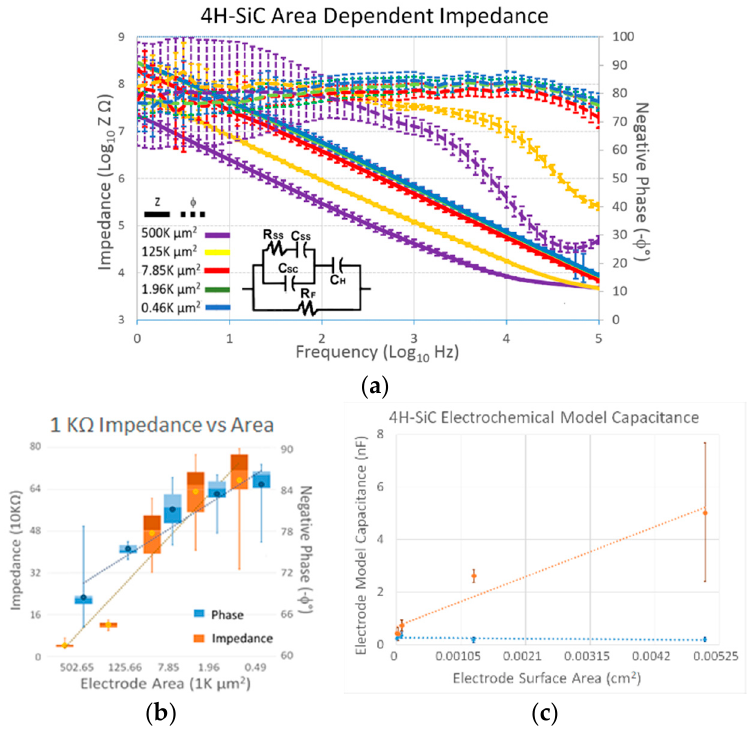
Figure 3. ( a ) Electrochemical impedance spectroscopy (EIS) performed on 4H ‐ SiC electrodes of varying geometrical surface areas (GSA). The error bars represent the standard deviation. The inset shows the basic circuit model which produced an impedance profile which was similar to that which was obtained in experimental investigation. ( b ) A box and whiskers plot for the impedance and phase of the 4H ‐ SiC electrodes at the frequency of 1 kHz across the 5 tested areas. The mean impedance and phase is represented with a dot. ( c ) The value of the space charge capacitance (CSC) obtained through the electrochemical modeling of the EIS for the 4H ‐ SiC electrodes divided by the geometric surface area of each electrode. All tests were performed in PBS that was naturally aerated (i.e., no N 2 /Ar gas bubbling to remove dissolved O 2 ) and possessed a pH of 7.4.